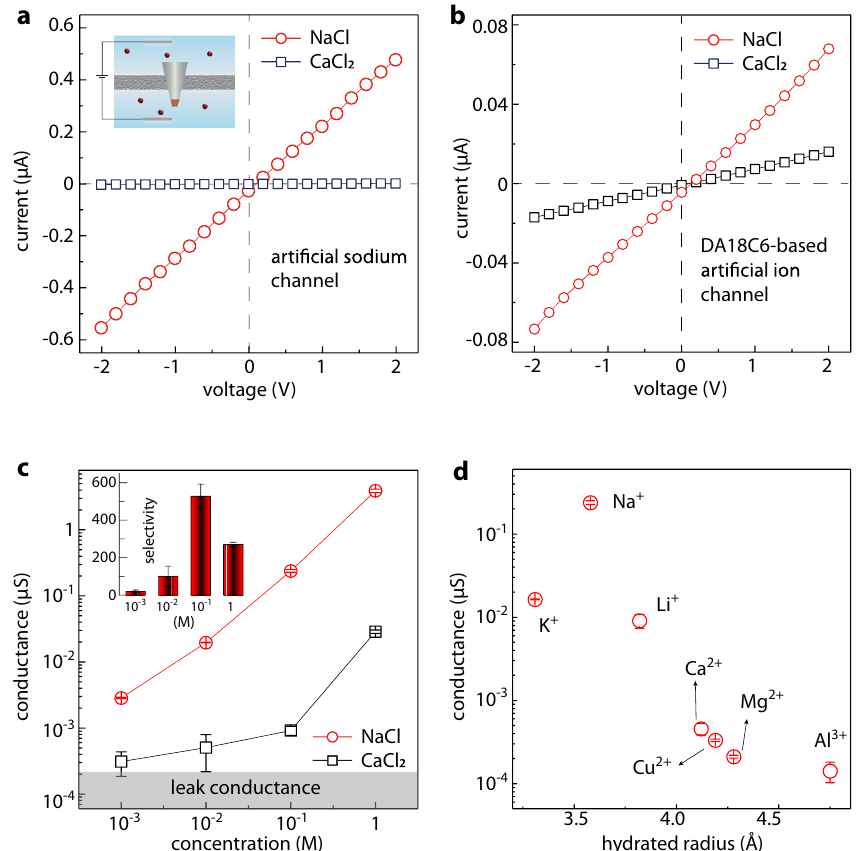
Fig. 3 Na + /Ca 2 + selectivity of the arti fi cial sodium-selective ionic device. a I – V curves for 0.1 M NaCl and 0.1 M CaCl 2 transporting through the arti fi cial sodium-selective ionic device. The Na + /Ca 2 + selectivity was calculated to be 523. Inset: schematic illustration of the setup. b To verify the important role of the porous crystal structure of the DA18C6-nitrate, we fabricated a noncrystalline-DA18C6-based arti fi cial ion channel, which displayed a dramatically lower selectivity of ~8. c The conductance of the NaCl and CaCl 2 through the arti fi cial sodium-selective ionic device as a function of concentration. Inset: calculated selectivity, showing a peak at 0.1 M. d The conductance of various 0.1 M chlorides, showing that the conductance generally decreases with the increase of hydrated radium, suggesting the importance of size selectivity. Error bars in all cases indicate the standard deviation of the